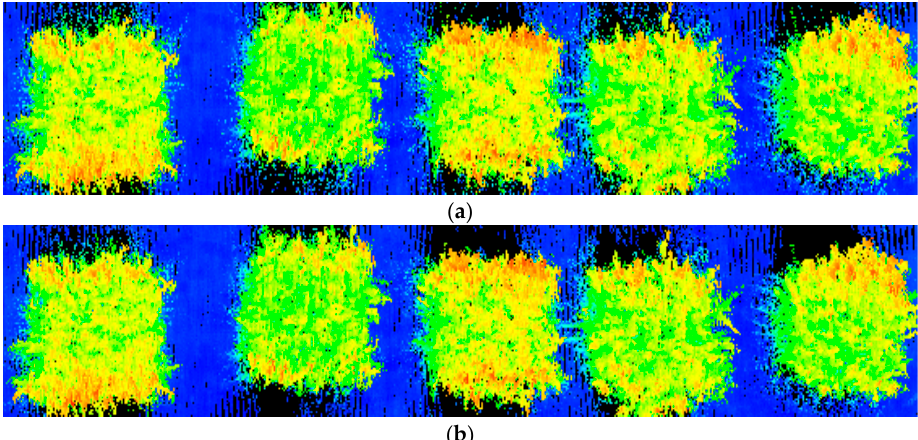
Figure 5. Denoising results of rice 3D point cloud data. ( a ) Before denoising. ( b ) After denoising.